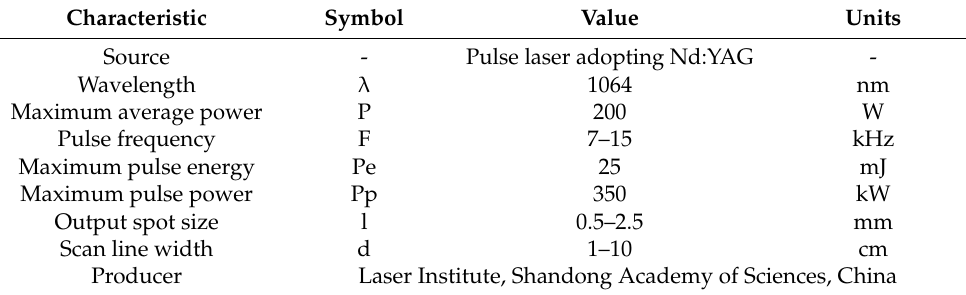
Table 2. The main parameters of the laser.